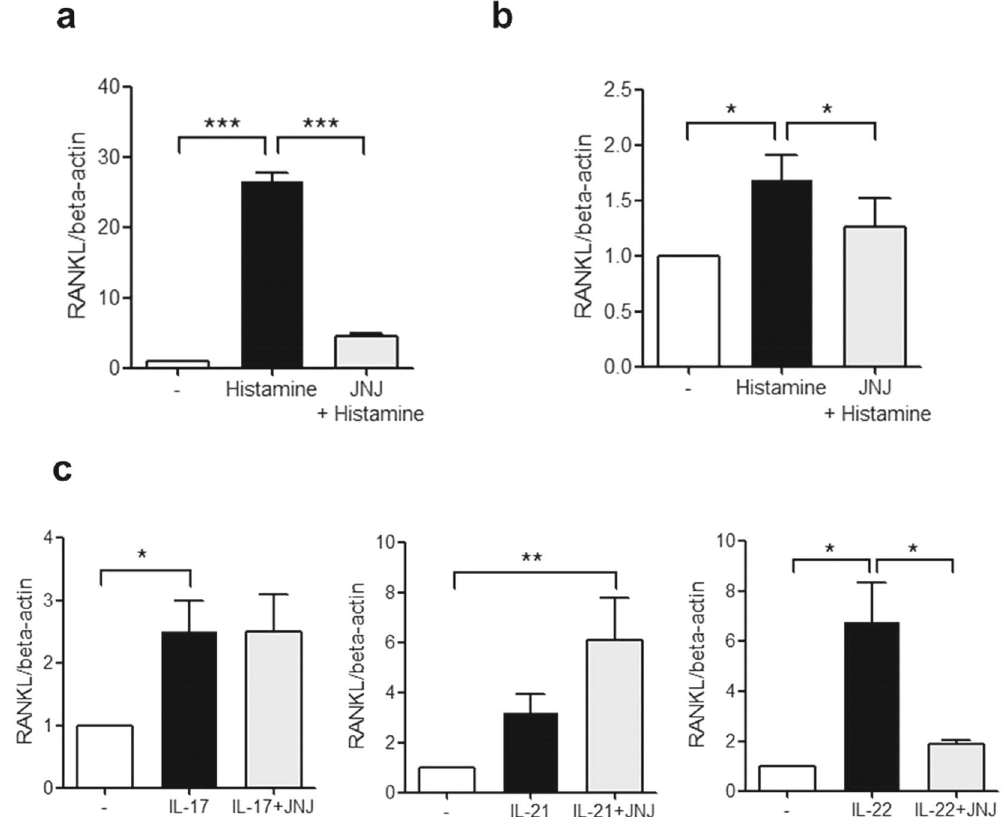
Figure 4. The expression of RANKL mRNA induced by histamine and Th17 cytokines. ( a ) After PB monocytes from 3 RA patients were cultured with 10 − 5 M of histamine and 10 μ M of JNJ7777120 for 16 h, the expression of RANKL mRNA was determined by real-time PCR. ( b ) After SF monocytes from 3 RA patients were cultured with 10 − 5 M of histamine and 10 μ M of JNJ7777120 for 16 h, the expression of RANKL mRNA was determined by real-time PCR. ( c ) After PB monocytes from 3 RA patients were cultured with IL-17, IL-21, IL-22 and 10 μ M of JNJ7777120 for 16 h, the expression of RANKL mRNA was determined by real-time PCR. Data were normalized to beta-actin and reported in relative expression units. The data represent the mean ± SEM of three independent experiments. * P < 0.05, and *** P < 0.001. H4R; histamine H4 receptor, JNJ;